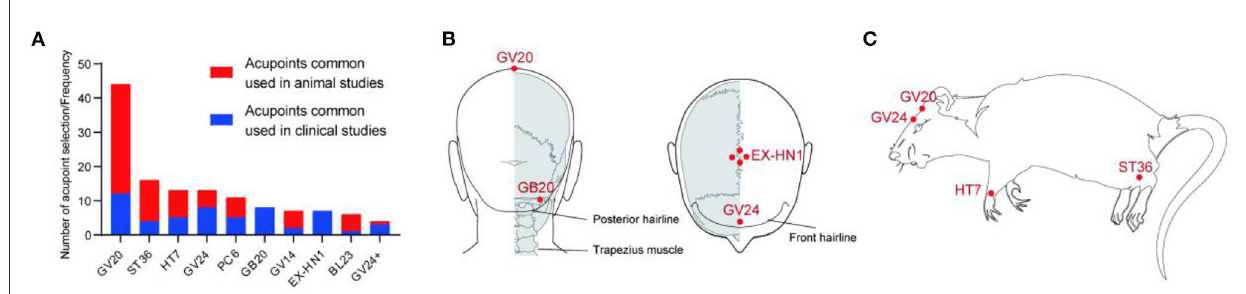
FIGURE3 The use frequency of acupoints and location of representative acupoints in animals and humans with PTSD. (A) The use frequency of acupoints, including animals and humans with PTSD. (B) The most commonly used acupoints for PTSD patients. (C) The most commonly used acupoint for PTSD model animals.